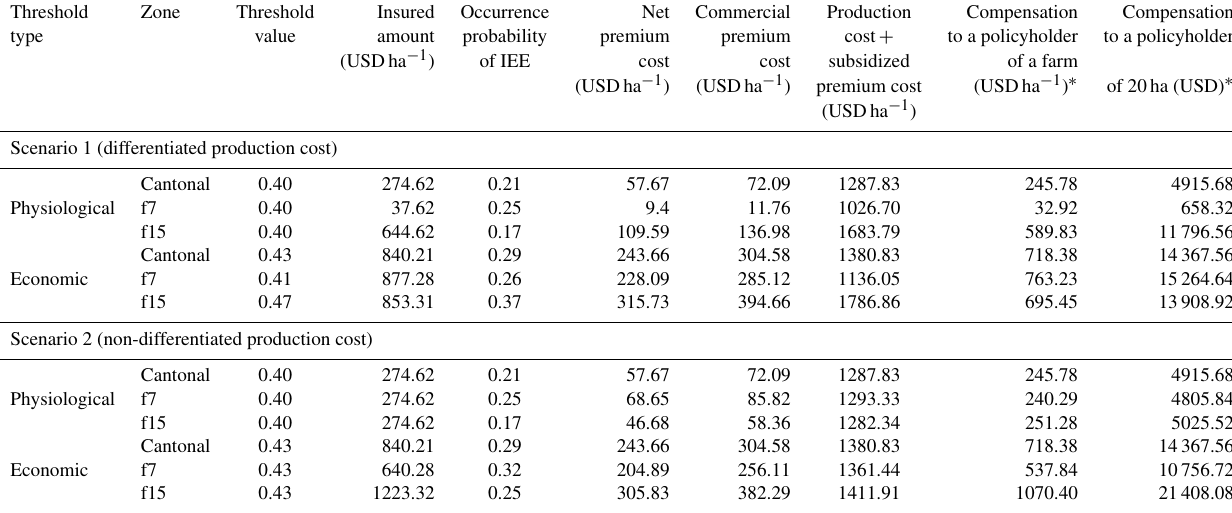
Table 8. Calculation of commercial premium rate for physiological and economic thresholds in scenarios 1 and 2 and for AHZs (f7 and f15) and cantonal